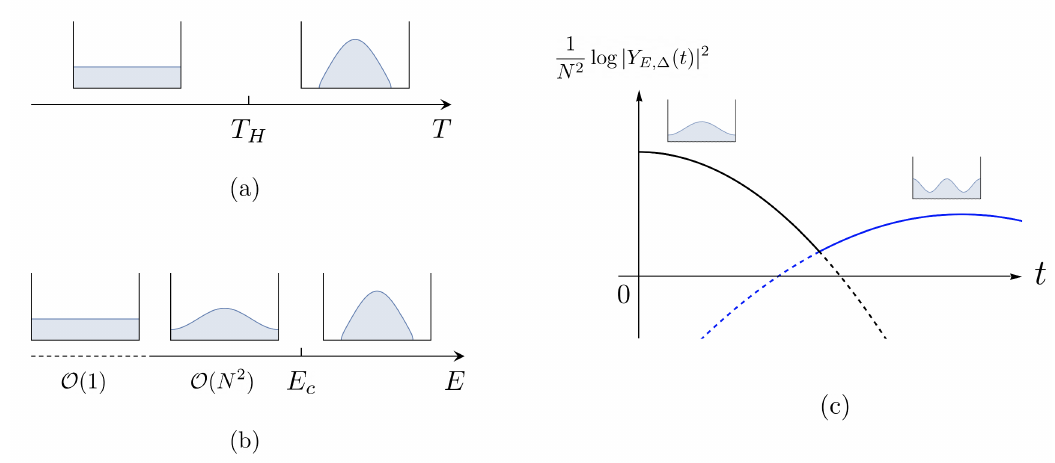
Figure 2 . (a) The Hagedorn transition in the canonical ensemble and the corresponding eigenvalue distributions. (b) Same transition but in the microcanonical ensemble. The Hagedorn temperature T H corresponds to a wide range of energy. (c) A snapshot of a possible behavior in the spectral form factor. The early time decay is replaced by a new saddle